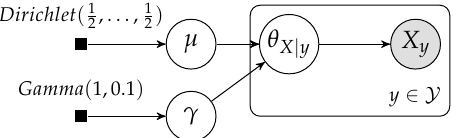
Figure 7. PGM for the hierarchical Dirichlet Multinomial model proposed in [10].